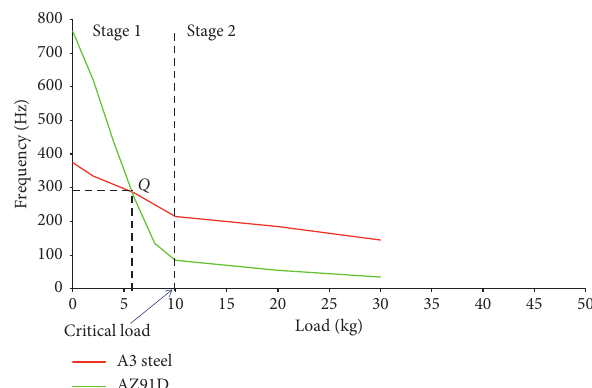
Figure 14: Frequency under different loading conditions for both materials swivel